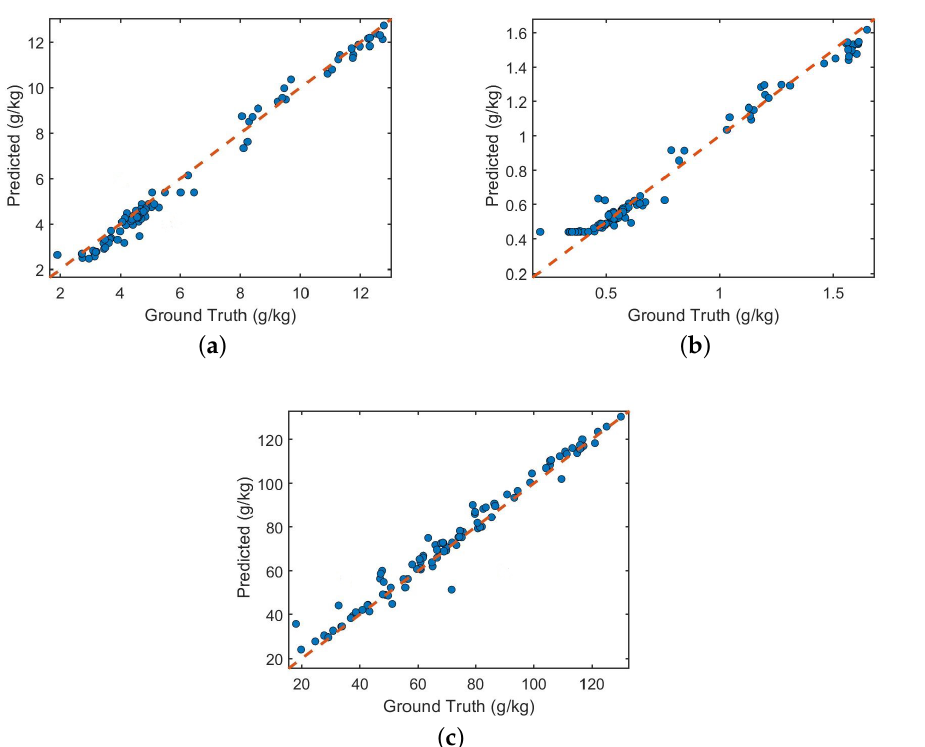
Figure 11. Actual vs. Predicted values of Proposed framework ( a ) Total Carbon ( b ) Total Nitrogen ( c ) Alkaline